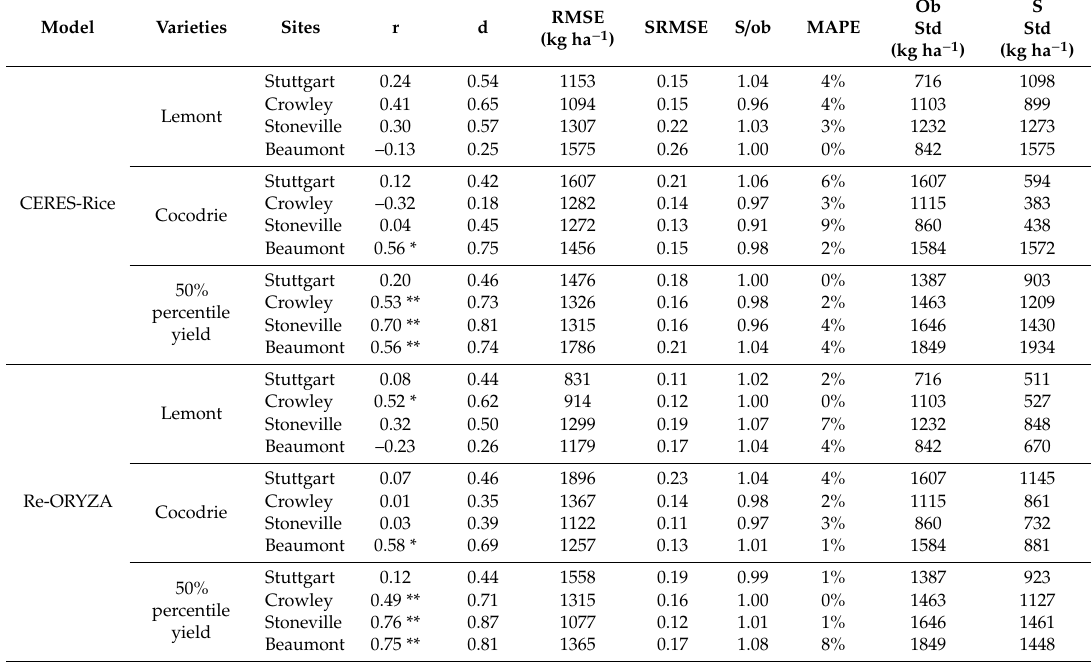
Table 4. Correlation coe ffi cient (r), root mean square error (RMSE), standard root mean square error (SRMSE = RMSE / average yield) between observed (Ob) and simulated (S) yields, ratio of simulated average yield to observed average yield (S / ob), the mean absolute percentage error (MAPE), and standard deviation of observed (Ob Std) and simulated (S Std) rice yield for varieties Lemont (1983–1998), Cocodrie (1999–2016), and comparison of 50% percentile yield of 101 varieties for 1983–2016 to simulated yield for cultivar Lemont (1983–1998) and Cocodrie (1999–2016). Models were CERES-Rice and a re-parameterized version of ORYZA.